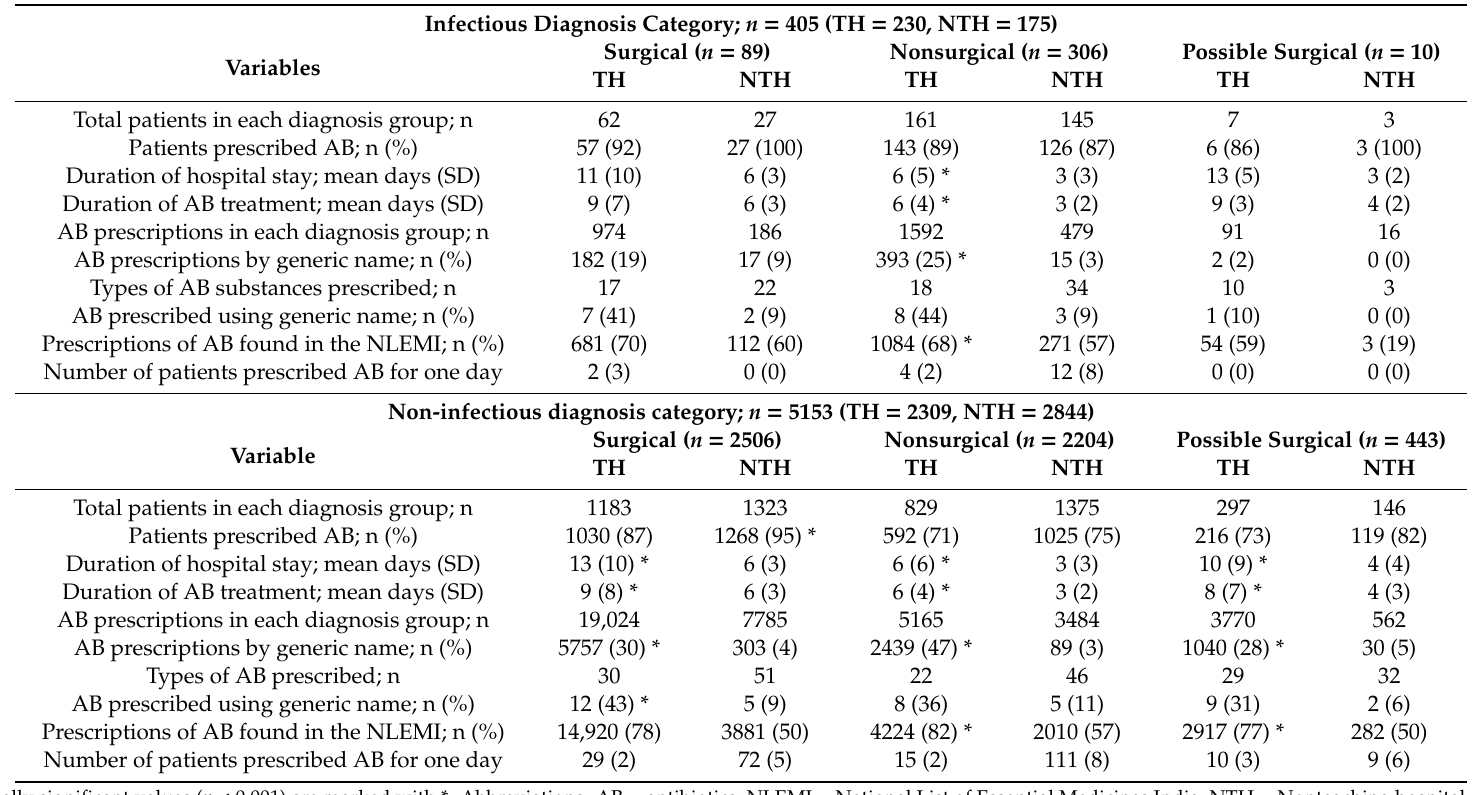
Table 2. Patients’ demographic and prescription details at the category and group levels among inpatients at the Obstetrics and Gynaecology departments of two private-sector hospitals, the TH and the NTH, in Central